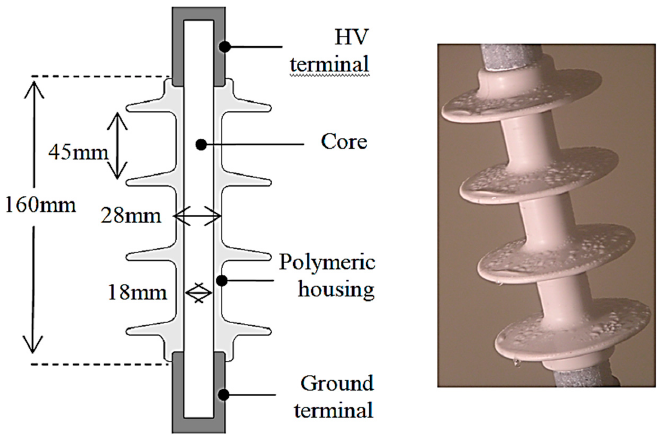
Figure 1. Insulator profile and dimensions.